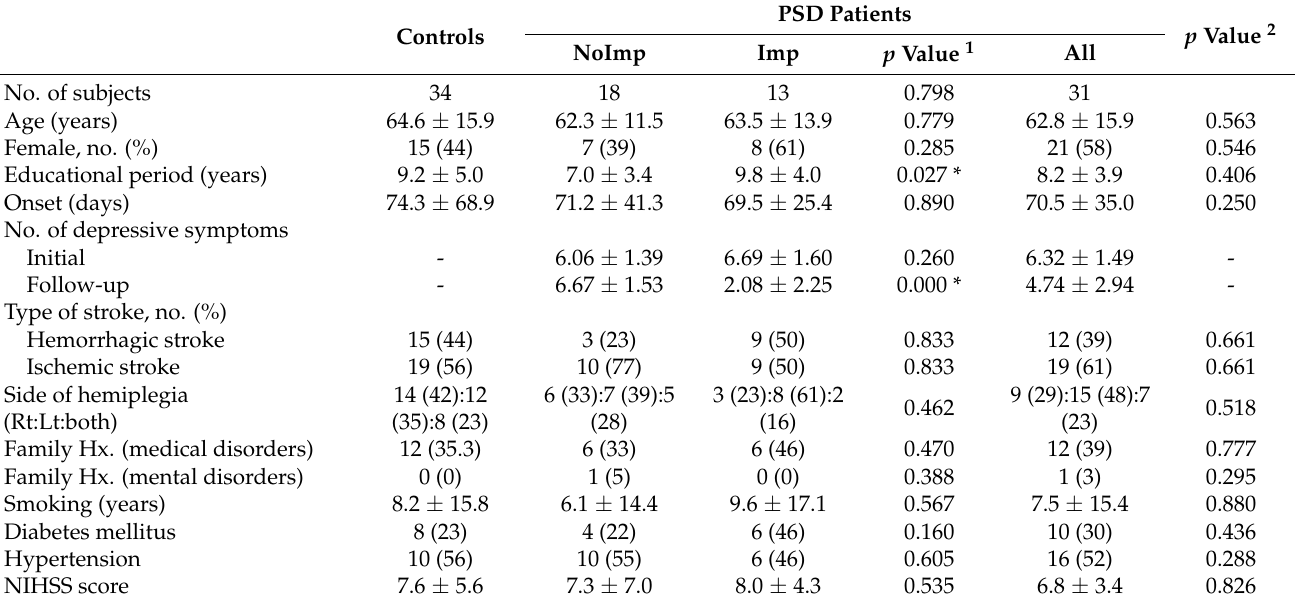
Table 1. Baseline characteristics of controls and patients with